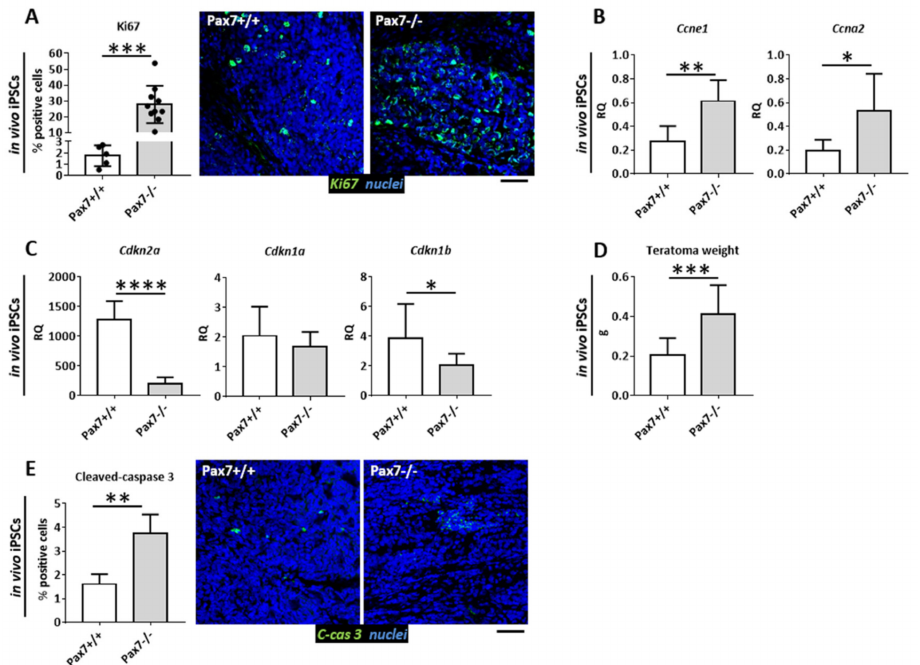
Figure 2. Cell proliferation and apoptosis in the teratomas generated from Pax7 +/+ and Pax7 − / − iPSCs. ( A ) Proportion of Ki67 positive (Ki67+) cells and immunolocalization of Ki67 (green) and nuclei (blue). Scale bar 100 µ m. ( B ) Expression of mRNAs encoding cyclin E1 ( Ccne1 ), cyclin A2 ( Ccna2 ). ( C ) Expression of mRNAs encoding p16INK4A ( Cdkn2a ), p21CIP1 ( Cdkn1a ), p27KIP1 ( Cdkn1b ). ( D ) Weight of teratomas. ( E ) Proportion of cleaved-caspase 3 (C-cas 3) positive cells and immunolocalization of cleaved-caspase 3 (green) and nuclei (blue). Scale bar 100 µ m. White bars— values for Pax7 +/+ teratomas; gray bars—values for Pax7 − / − teratomas. Expression was related to the levels observed in 13.5 d.p.c. mouse embryo (E13.5) and normalized to mRNA encoding β -actin ( Actb ). Data are presented as mean ± SD. Stars symbolizes results of Student’s unpaired two-tailed